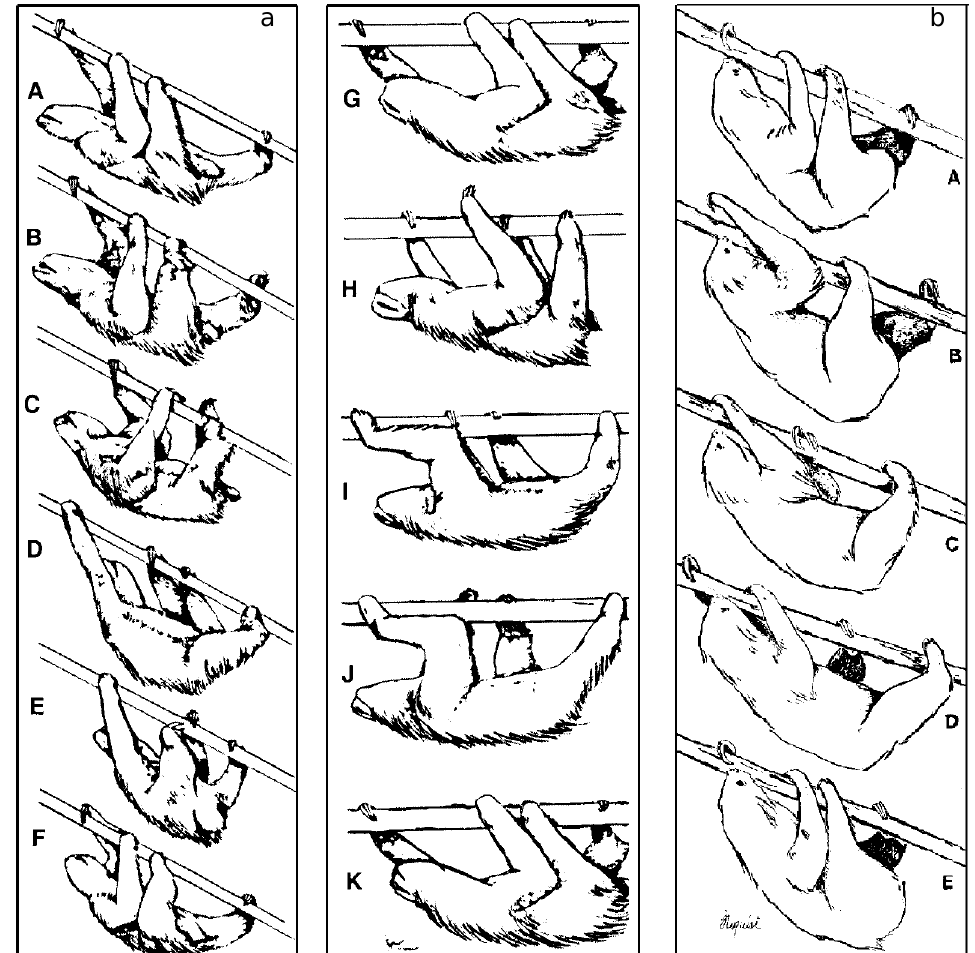
Figure 5 - a , Typical sequence of locomotion of Bradypus variega- tus along a branch inclined at ap- proximately 30 o (A-F) and along another in the horizontal position (G-K). (Reproduced with permis- sion from Mendel, 56). b , Typical sequence of locomotion of Cho- loepus hoffmanni along a branch inclined approximately 30 o in re- lation to the horizontal. (Repro- duced with permission from Mendel,